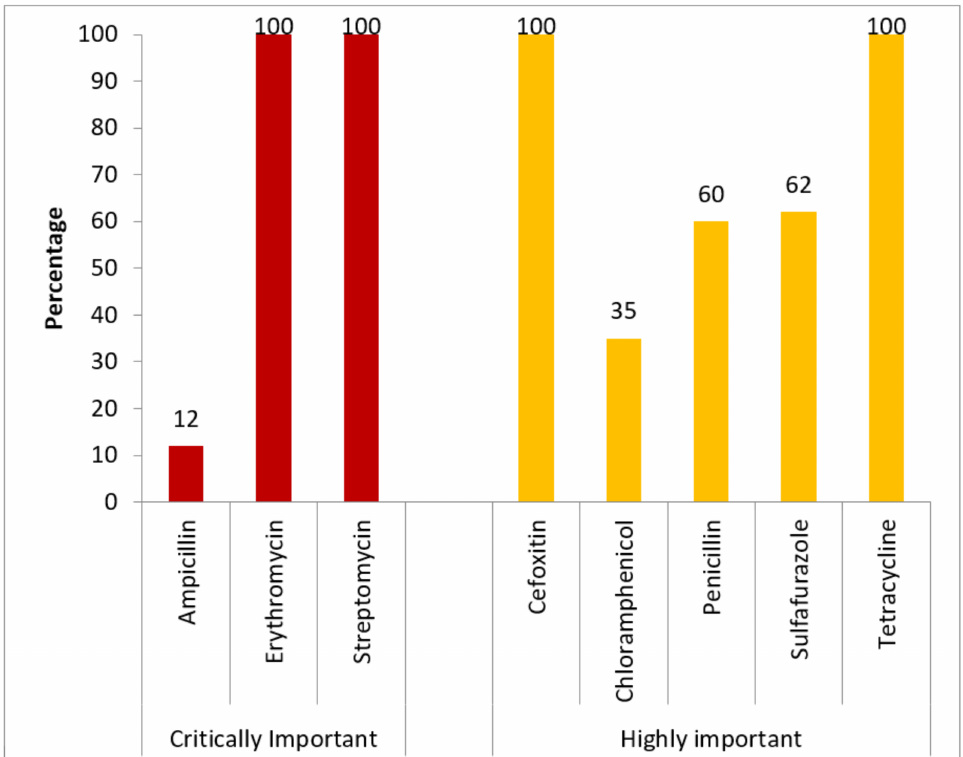
Figure 2. Antibiotic resistance disaggregated by WHO Critically important * classification for E.